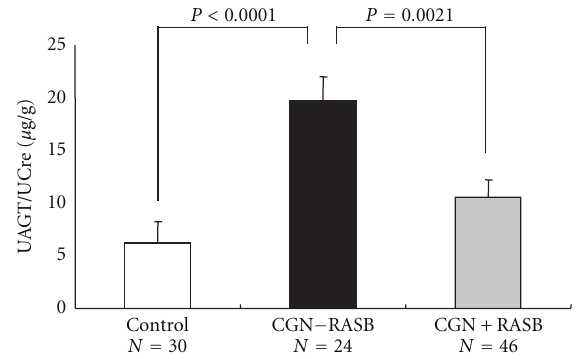
Figure 2: Urinary AGT-creatinine ratio in chronic glomeru- lonephritis patients (CGN) with/without renin-angiotensin system blockade (RASB) and in control subjects. Cited from Am J Nephrol 2010; 31: 318-325 by Urushihara et al.